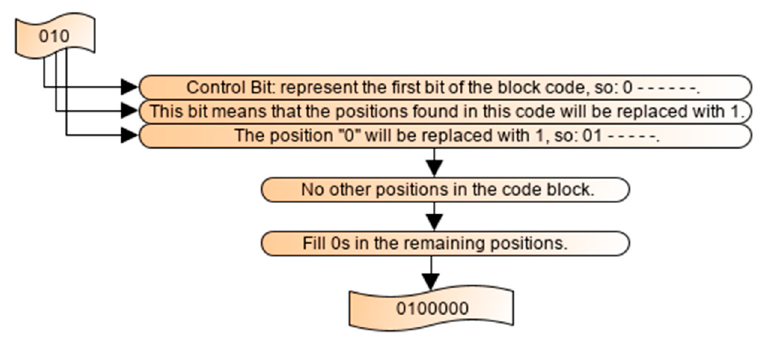
Figure 6. The decoding process of the first compressed code block.